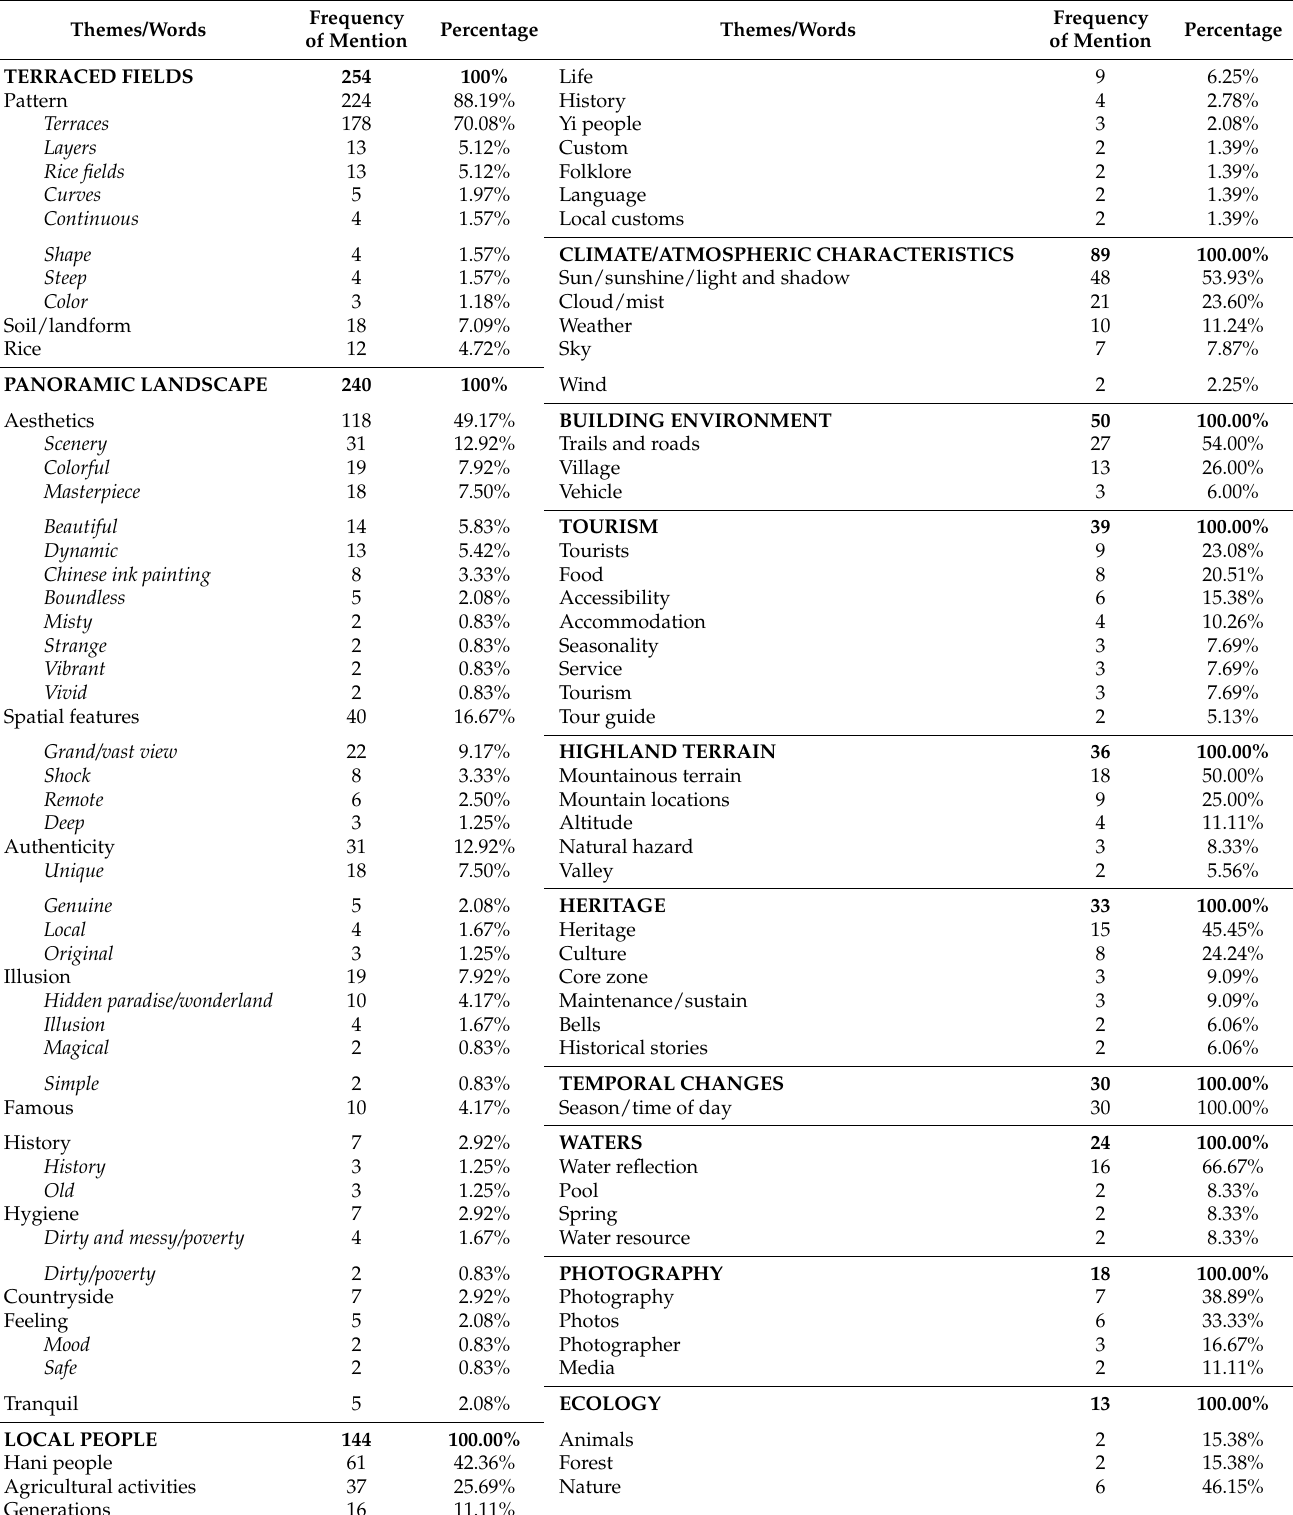
Table 1. Frequency of words mentioned 1 in tourists’ comments about Honghe on Mafengwo.cn